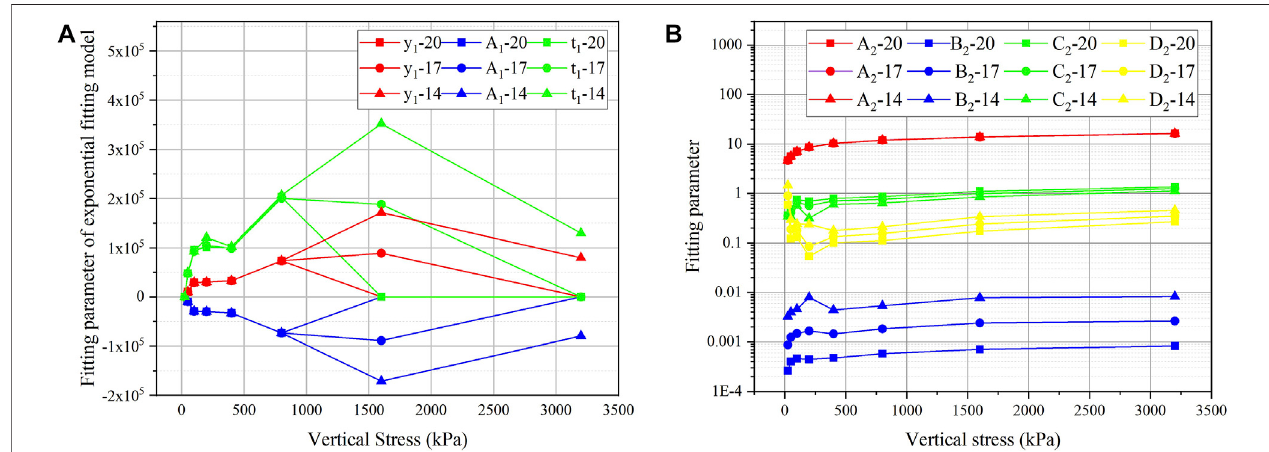
Frontiers in Physics |